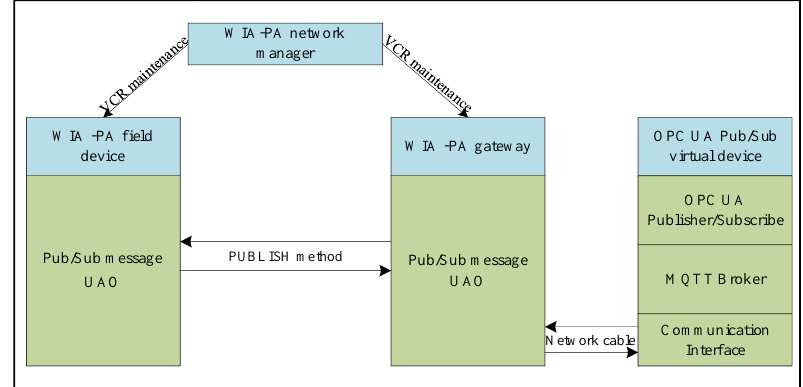
Figure 11. WIA-PA/OPC UA joint pub/sub interaction process.